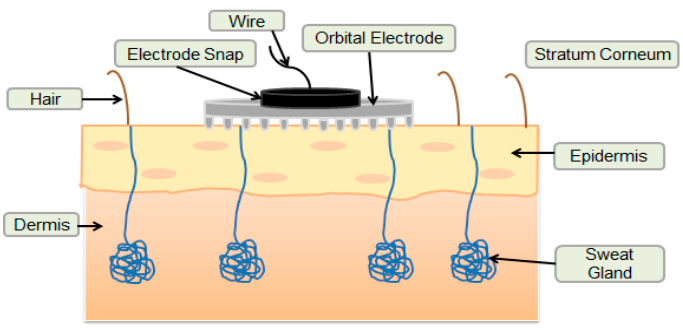
Figure 1. Orbital electrode’s penetration into the skin layers during bio-signal recording.